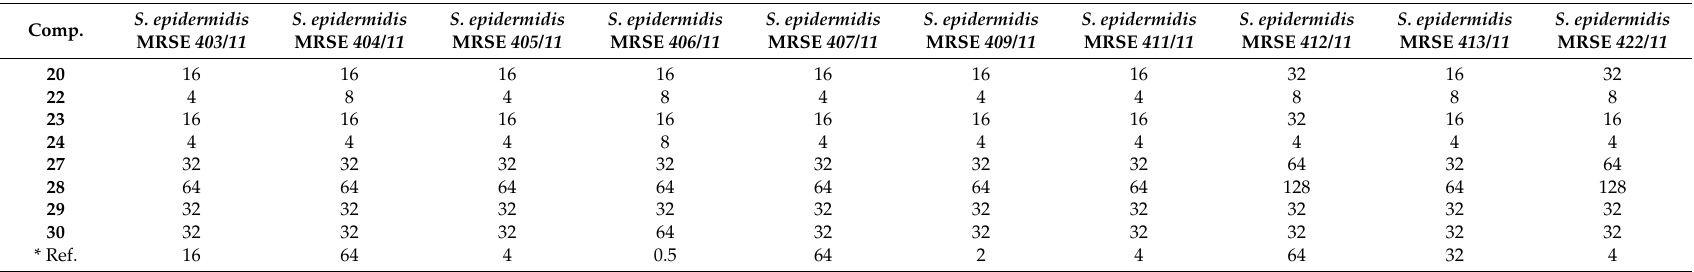
Table 3. Activity of compounds against hospital methicillin-resistant strains of Staphylococcus epidermidis (MRSE)—minimal inhibitory concentrations (MIC, µ g/mL).